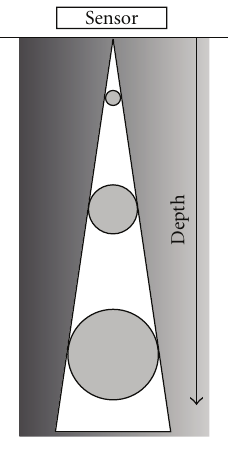
Figure 2: Sensitivity cone of a gravity gradient